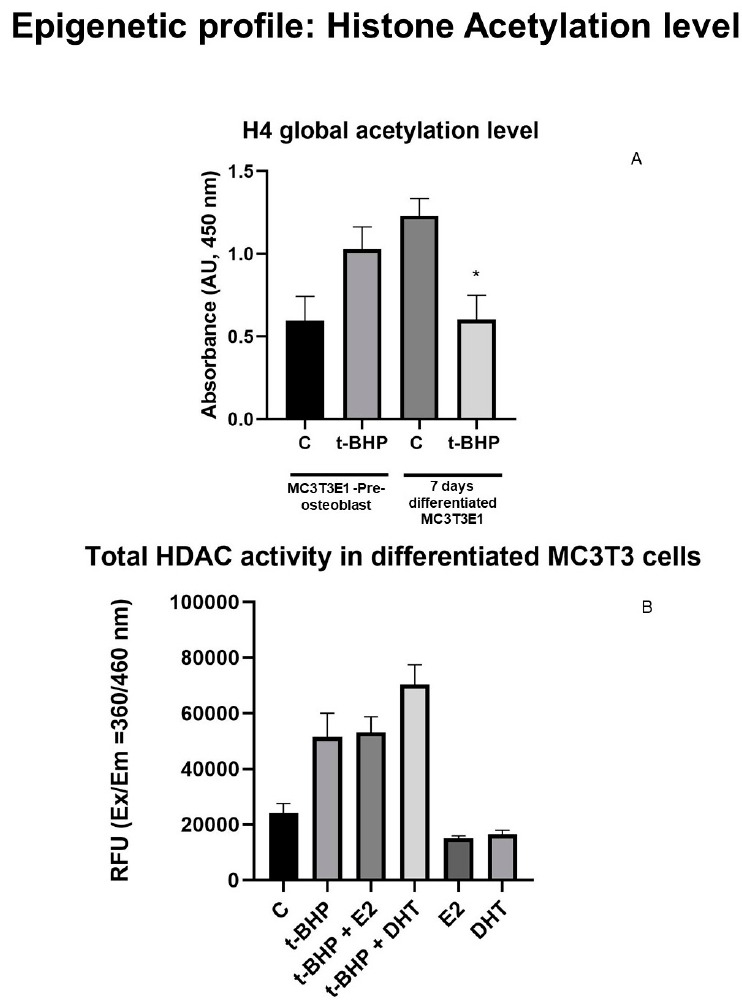
Figure 6. Effects of oxidative stress and steroids on histone acetylation. Effects of exposure to t-BHP (250 µ M in pre-osteoblastic cells and 125 µ M in 7 days differentiated cells) and steroids (10 − 9 M) on histone acetylation. ( A ): effect of t-BHP on H4 global acetylation level in pre-osteoblasts and differentiated osteoblasts. t-BHP reduces the H4 acetylation level only in differentiated osteoblasts. * p < 0.05 vs. control. ( B ): effects of steroids (10 − 9 M) in differentiated osteoblasts MC3T3-E1 cells exposed to t-BHP (125 µ M, 3 h) on total HDAC enzymatic activity. According to previous data, t-BHP induces the enzymatic activity of HDAC. Steroids treatment does not restore HDAC activity to the control level. Data are represented as the mean ± SEM of six replicates within a single experiment. Differences between groups were evaluated by one-way ANOVA followed by Bonferroni post-hoc test. The experiment was repeated twice. * p < 0.05 vs.